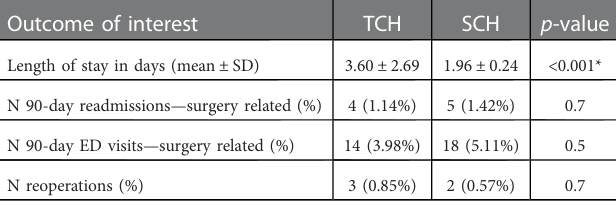
TABLE 2 Comparison of TCHs and SCHs on outcomes of interest. Outcome of